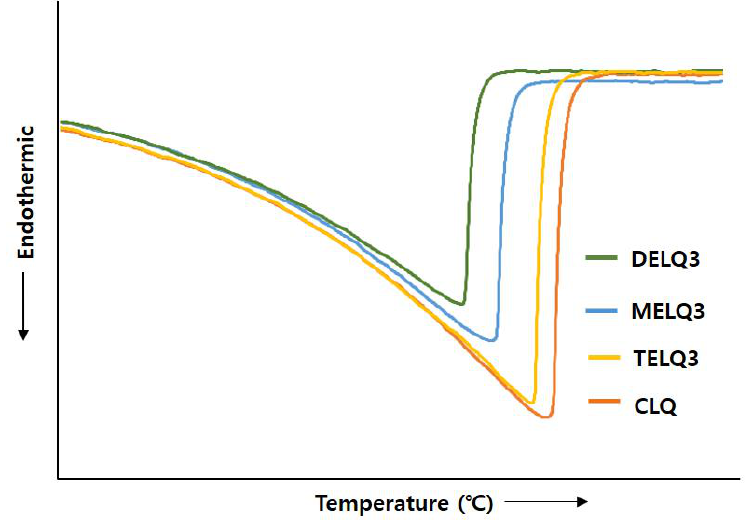
Figure 3. Effect of nanoliposomes on the differential scanning calorimetry (DSC) thermograms of conventional nanoliposome (CLQ), MELQ3, DELQ3, and TELQ3.